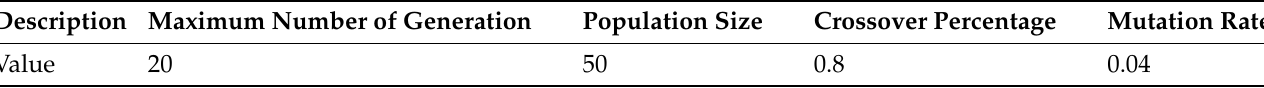
Table 3. Settings of genetic